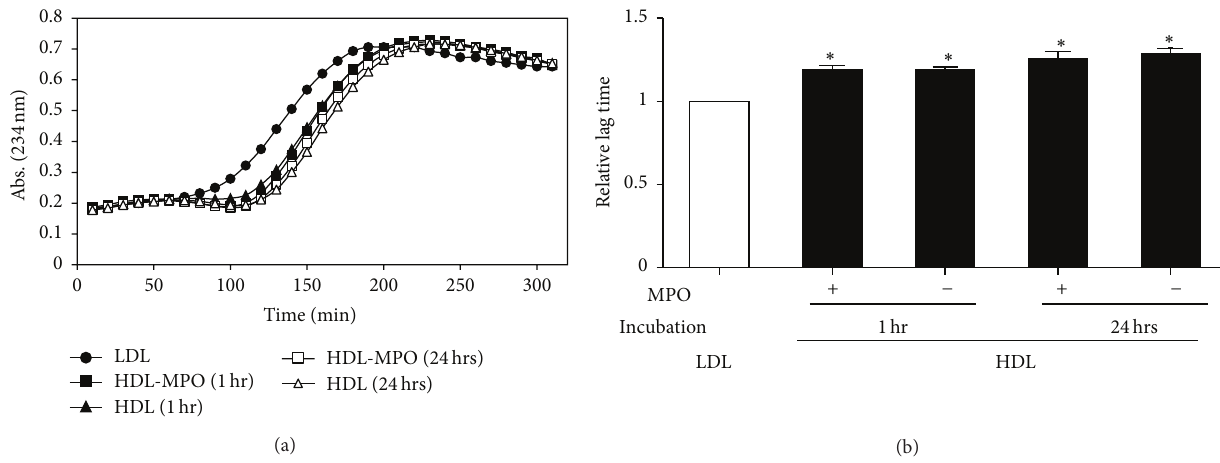
Figure 3: Antioxidant ability of HDL treated with and without MPO. LDL (50 𝜇 g protein/mL) was oxidized by 1 𝜇 M copper sulfate without (black circle) and with (other symbols) 50 𝜇 g protein/mL HDL samples described in Figure 1. (a) Representative oxidation kinetics were obtained by monitoring diene formation at 234 nm at room temperature. (b) Relative lag times are shown (the lag time of LDL alone is defined as 1). Data represent the mean ± SD of three independent experiments. ∗ 𝑃 < 0.01 versus LDL.